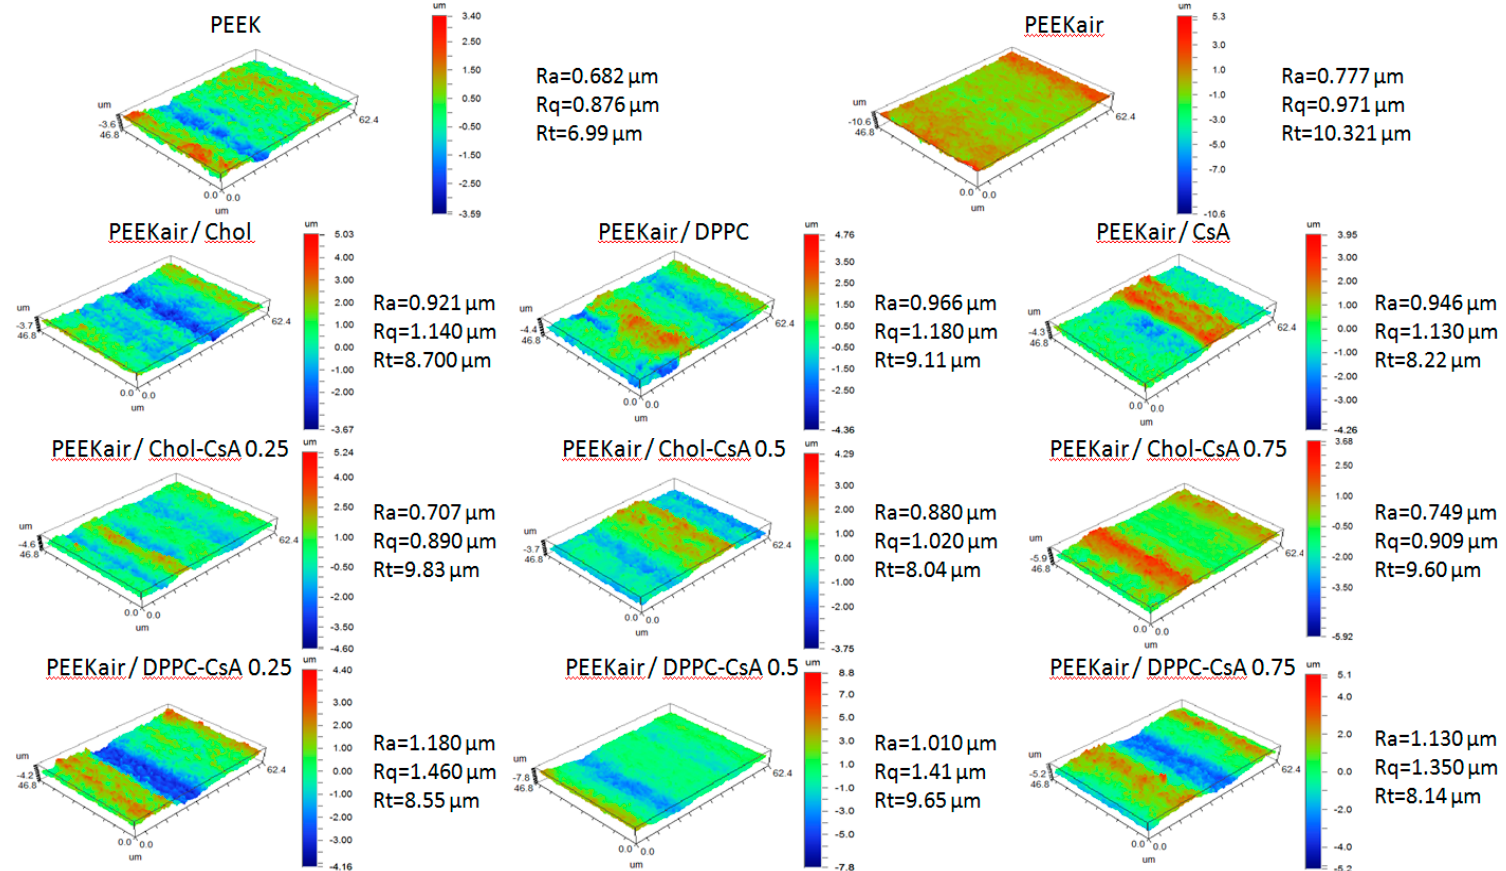
Figure 8. The most representative images of the obtained PEEK surfaces (62 × 47 μ m 2 ) with the roughness parameters.